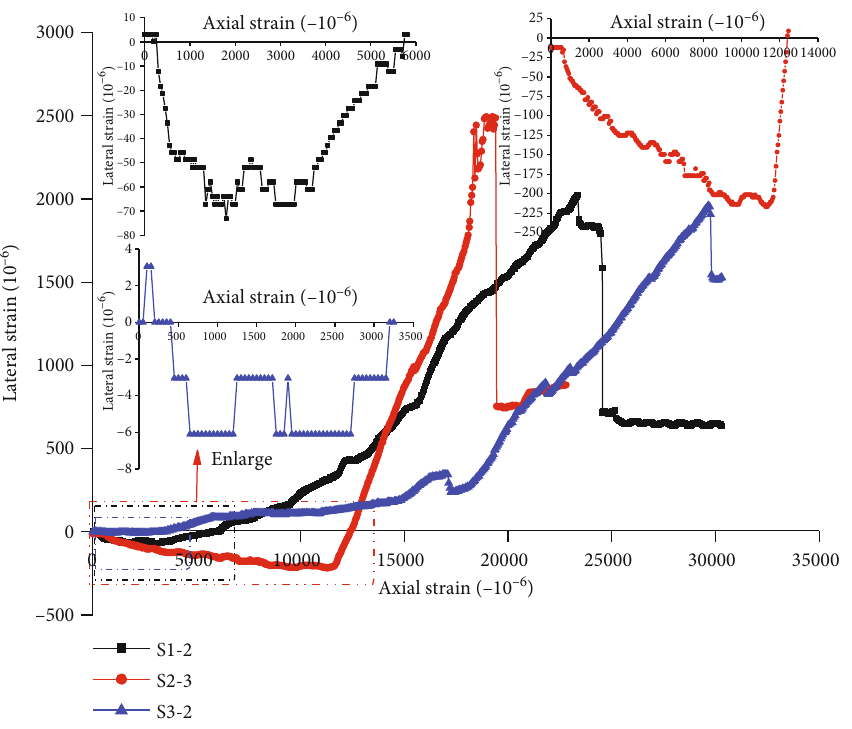
Figure 4: Lateral and axial strain curves of the representative sandstone